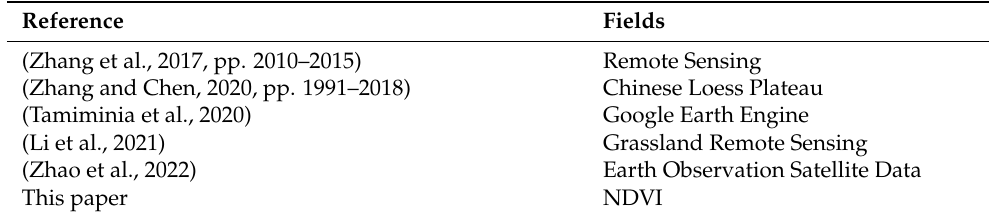
Table 1. List of previous studies using the bibliometric